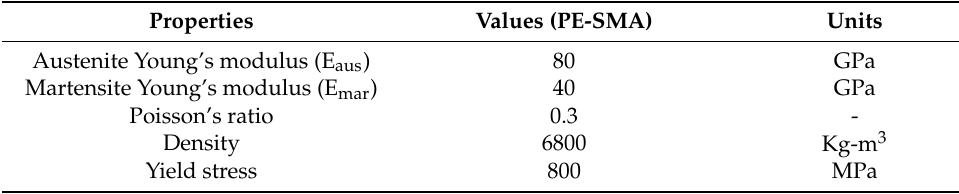
Table 1. Material properties of pseudo-elastic (PE)-SMA.